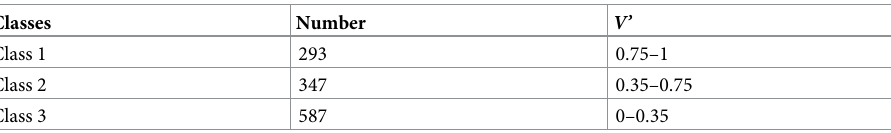
Table 6. Number and V’ of each class of